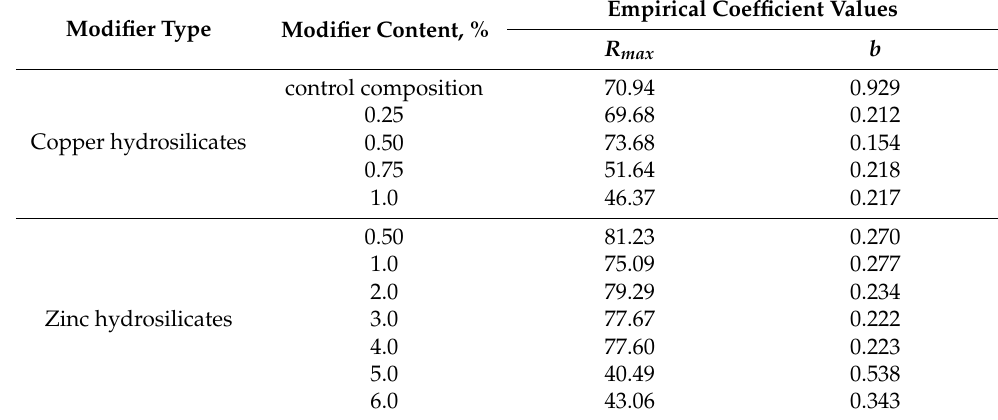
Table 4. Empirical coefficient